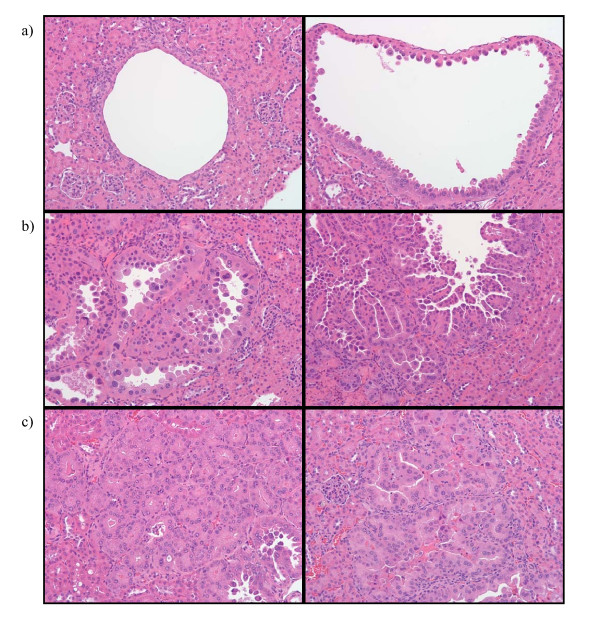
Examples of the three different subgroups of kidney cystadenomas in Tsc2+/- mice. All pictures were taken at a 20× magnification. a) Cystic lesions. b) Papillary lesions. c) Solid lesions.